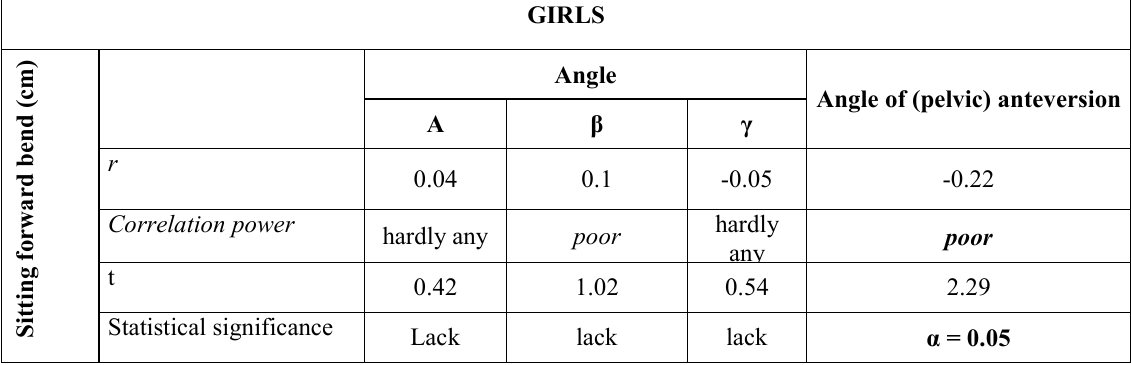
Correlations occurring between the angles characteristic of anterior-posterior pelvic tilts (upper thoracic - α, thoracic- lumbar - β, sacral-lumbar γ) and the angle of pelvic anteversion in the sagittal plane and the number of points scored in the sitting forward bend test in the girls involved in the study